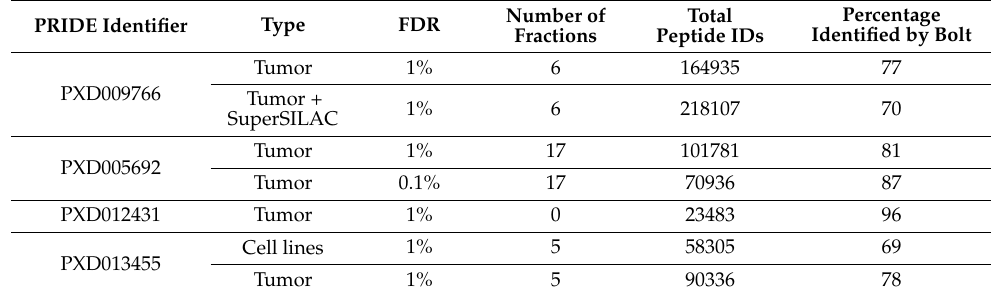
Table 2. Bolt results compared with various other breast cancer studies whose data are publicly available. The percentages of peptide IDs common between each study and the data presented here are